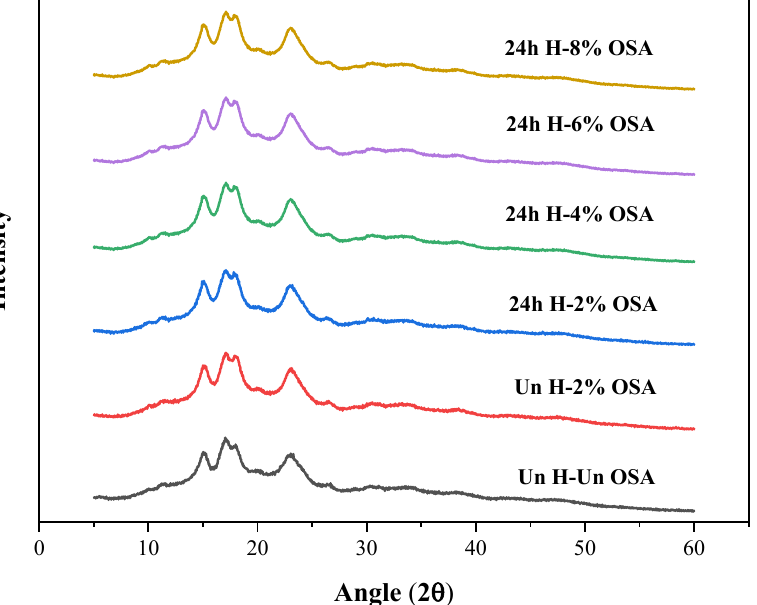
Figure 1. XRD patterns of OSA-modified and native high-amylose PMS (Kudzu) starch samples.